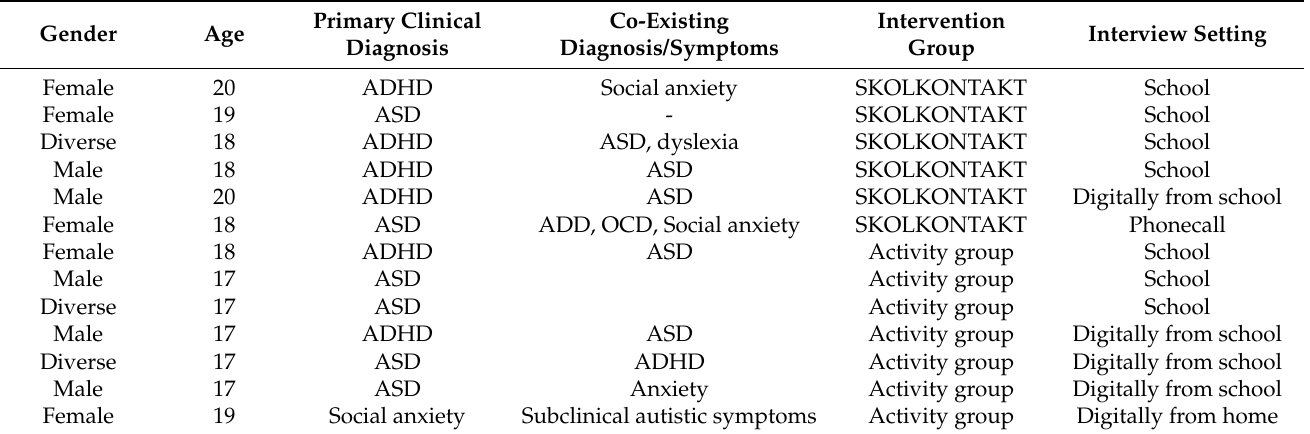
Table 1. Student participant